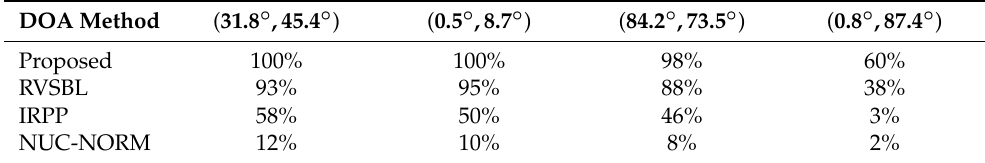
Table 1. Accuracy with different DOAs of